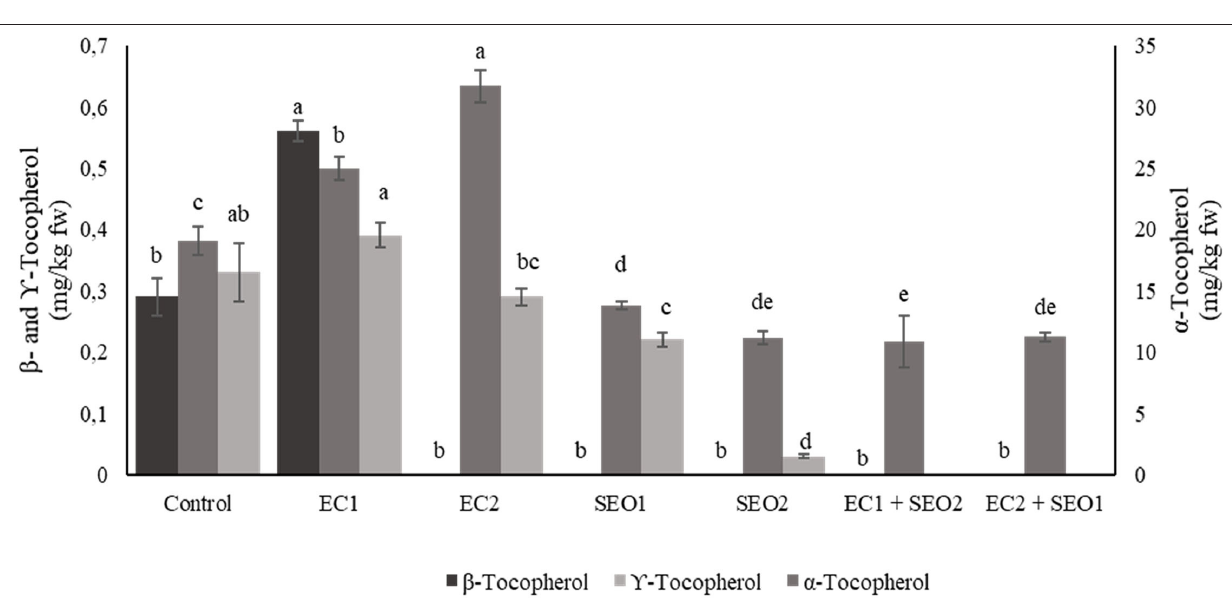
FIGURE 7 | HRSA and LRSA ( µ M Trlox/100g fw) of tomato fruits under control (C, 0.4 dS/m), saline (EC1, 3.5 dS/m; EC2, 7 dS/m), spent engine oil stress (SEO1, 0.5%; SEO2, 1%) and the combinations (EC1/SEO2, 3.5 dS/m EC/1% SEO), (EC2/SEO1, 7 dS/m EC/0.5% SEO). Values are means ( n =